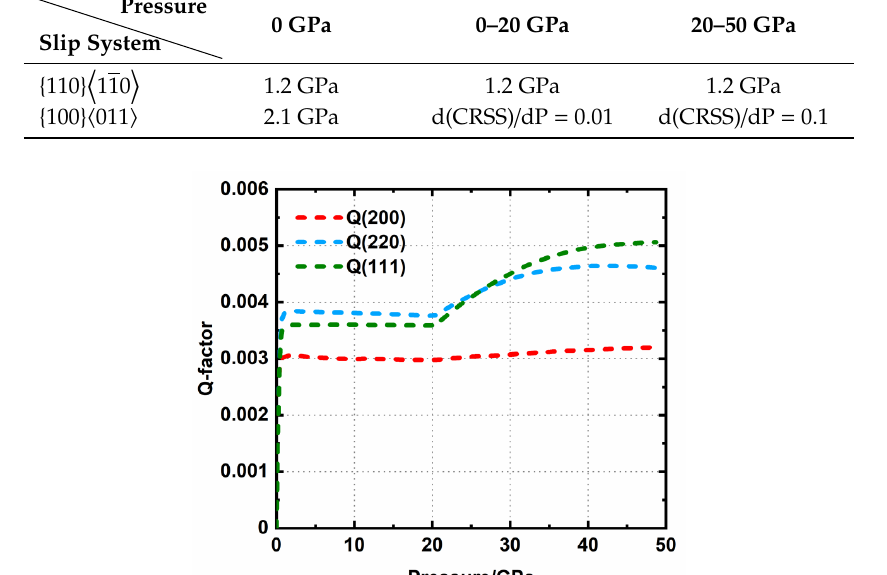
Figure 5. Texture evolution in the EVPSC simulation .